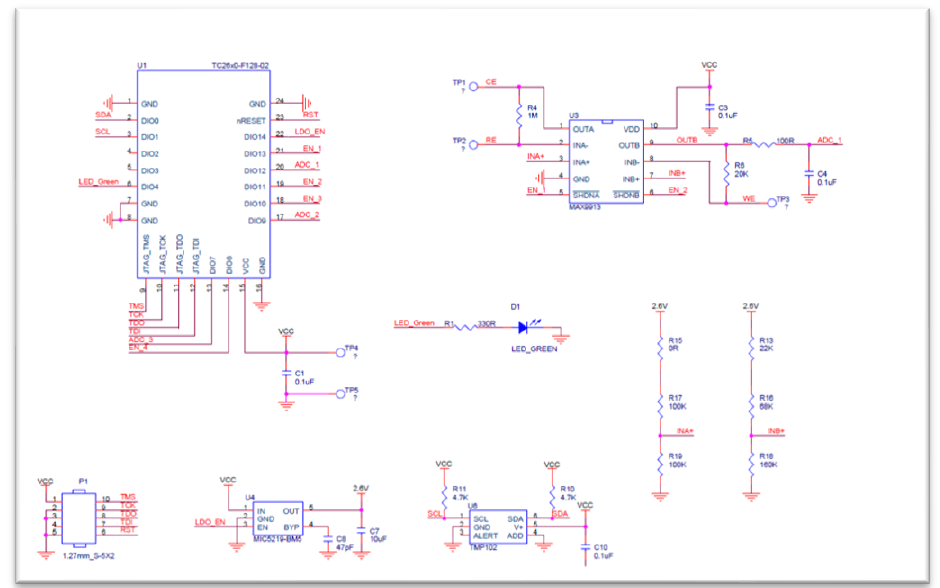
Figure 11. The circuit diagram of the MAX9913 operational amplifier.